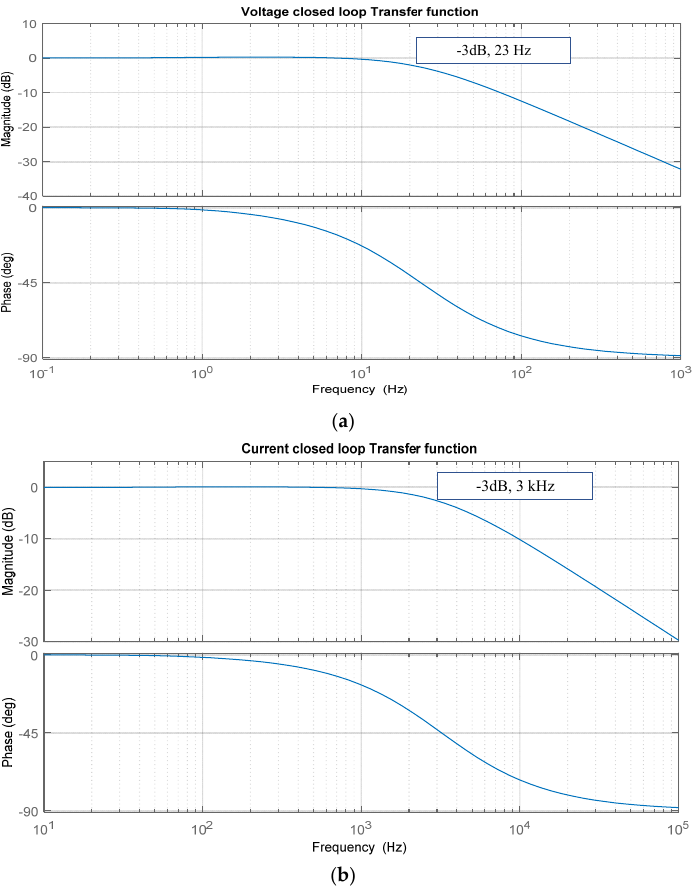
Figure 10. Bode plots for the control loops for the conventional CCM PFC converter: ( a ) voltage control loop; ( b ) current control loop.